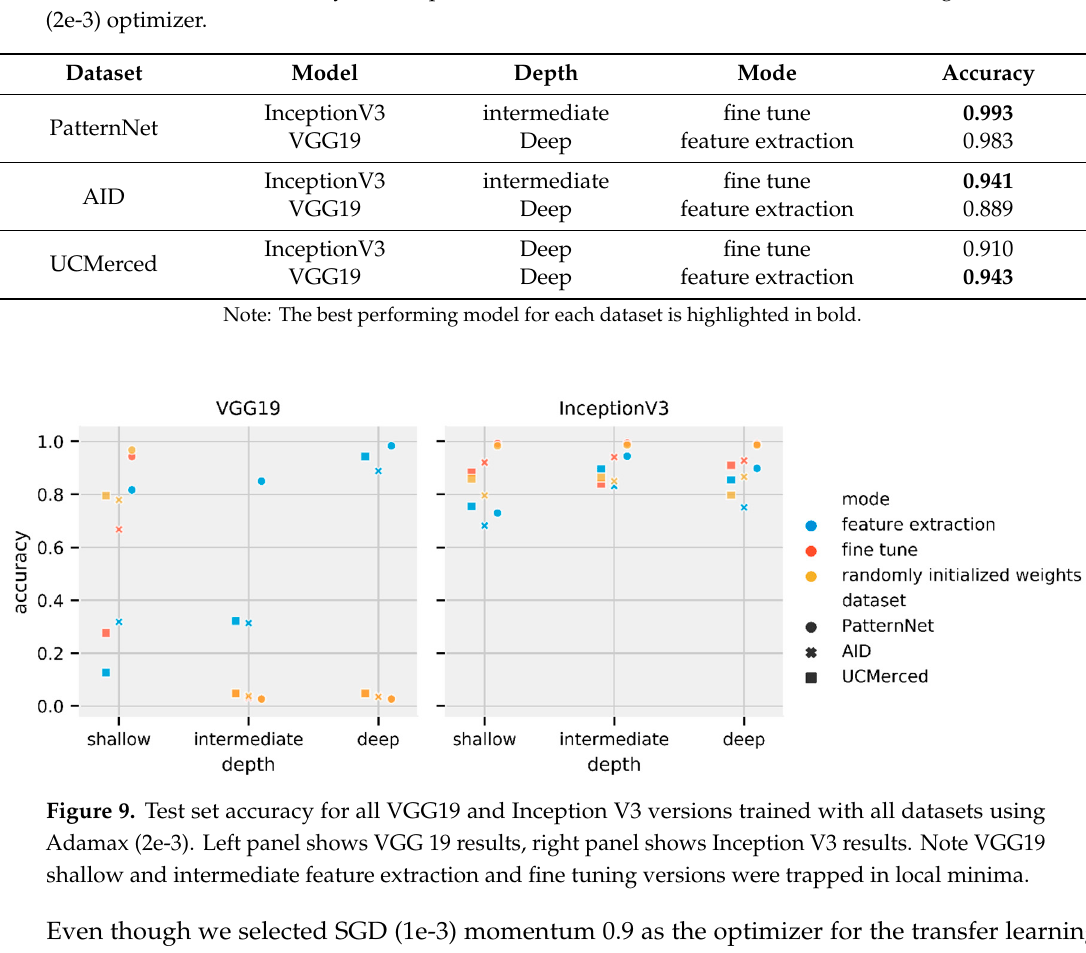
Figure 8. Test set accuracy for all VGG19 and Inception V3 versions trained with all datasets using SGD (1e-3) momentum 0.9. Left panel shows VGG 19 results, right panel shows Inception V3 results. Note VGG19 shallow and intermediate feature extraction and fine-tune versions were trapped in local minima. Some of the points in local minima appear wine-colored as the blue (feature extraction) points and red (fine tune) points are very closed and partially overlaying each other. Table 8. Best test set accuracy for Inception V3 and VGG19 version for each Dataset using SGD (1e-3) momentum 0.9 optimizer to perform transfer learning on models initially trained on PatternNet.